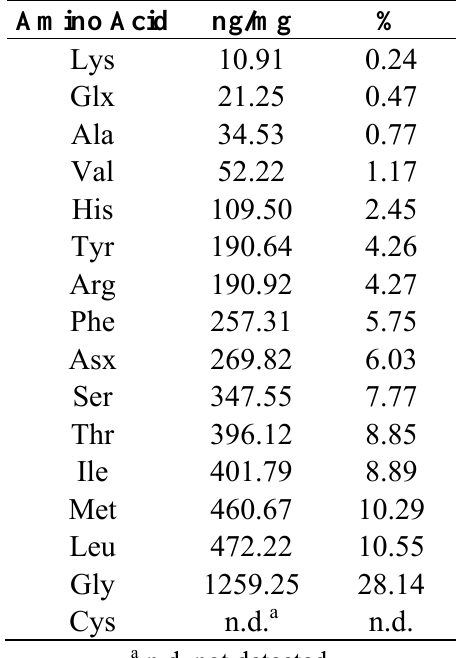
Table 2. Amino acid composition of the tepary bean